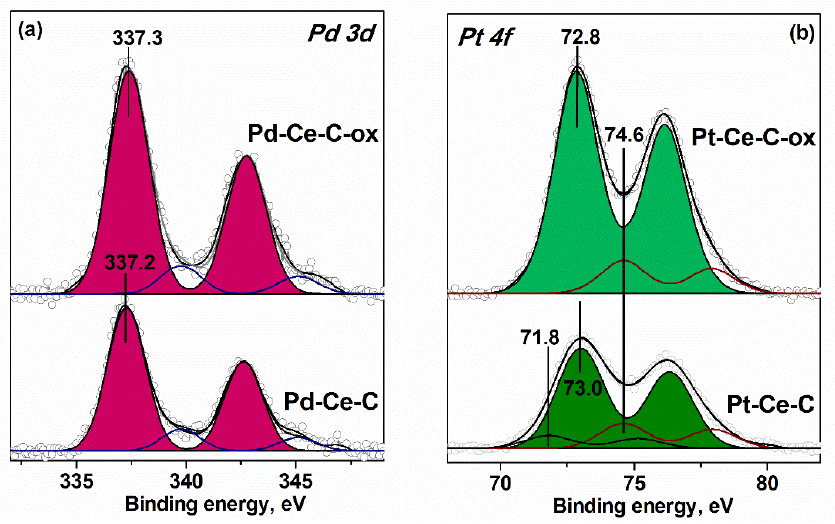
Figure 4. XPS data. ( a ) Pd3d spectra of Pd-Ce-C and Pd-Ce-C-ox samples; ( b ) Pt4f spectra of Pt-Ce-C and Pt-Ce-C-ox samples. ((o-o) lines correspond to the experimental spectra). For both the Pd-Ce-C and Pd-Ce-C-ox samples, there is one main spin-orbit split Pd3d 5/2 -Pd3d 3/2 doublet in Pd3d spectrum with E b (Pd3d 5/2 ) at 337.2–337.3 eV. According